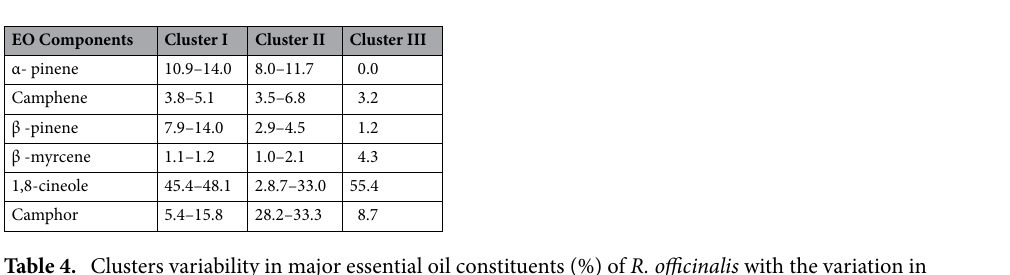
Table 4. Clusters variability in major essential oil constituents (%) of R. officinalis with the variation in seasons and accessions.